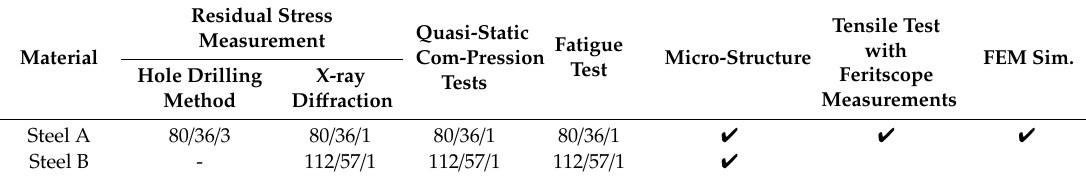
Table 2. Overview of Experimental and Numerical